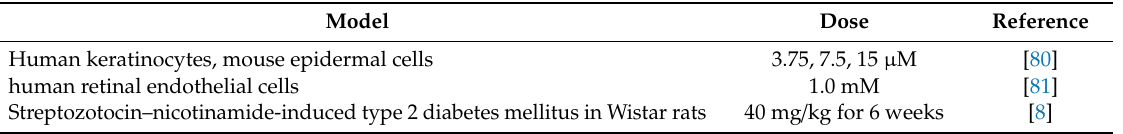
Table 3. Model and dose of antioxidation activity of pterostilbene.